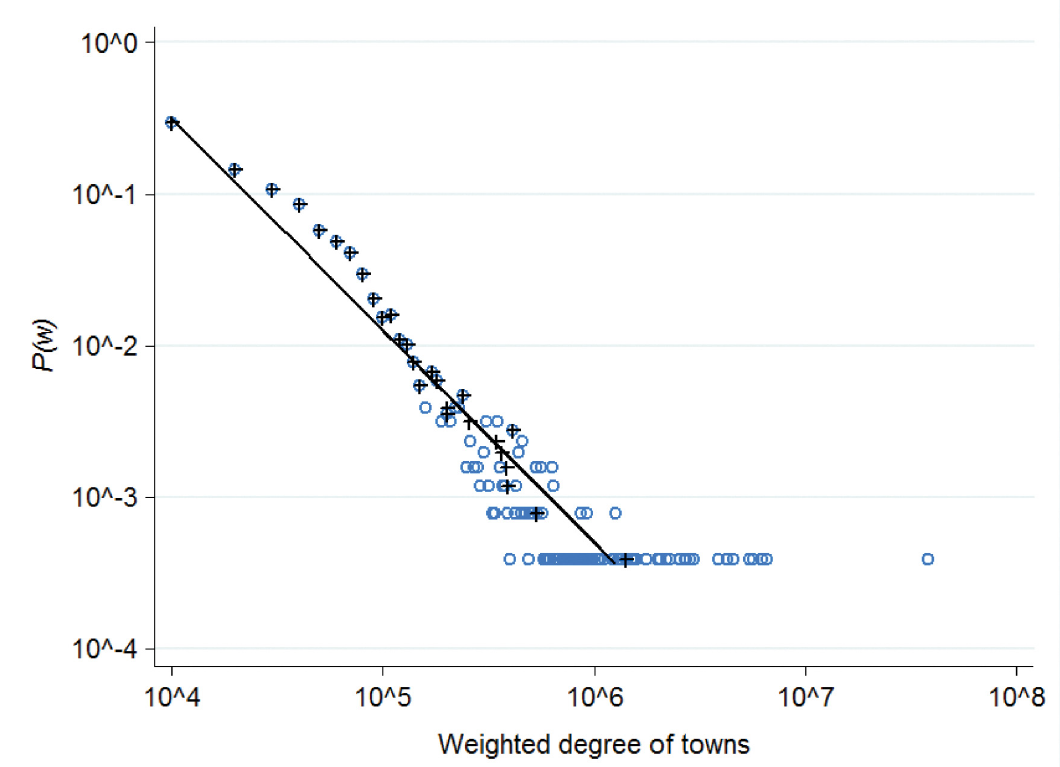
Fig 1. Degree distribution. Weighted degree distribution of town network, loops excluded. Weights are the total number of user-to-user links between two towns. Weighted degrees were binned into 10 4 intervals for P ( w ) calculation; blue hollow circle symbols represent the bins; black plus symbols represent the mean of weighted degree by each unique value of P ( w ). The slope of the solid line is -1.4, which fits P ( w ) values with R 2 =